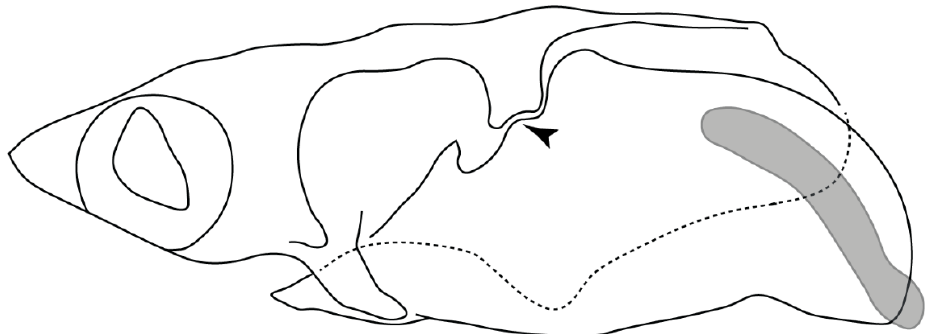
Figure 22. State (1): Interpretative drawing of the neurocranium of Heptranchias perlo redrawn and modified from Maisey Text-Figure 3C in [92]. Arrowhead: Postorbital articulation. Hyomandibula in gray color.